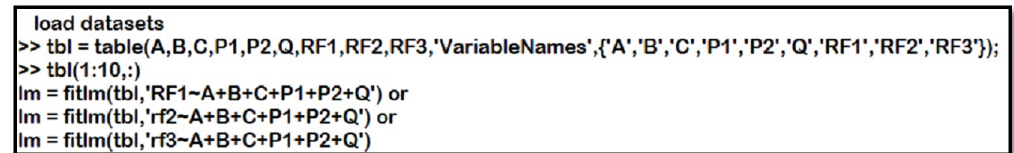
Figure 6. Function used under MATLAB environment to proceed with MLR prediction.